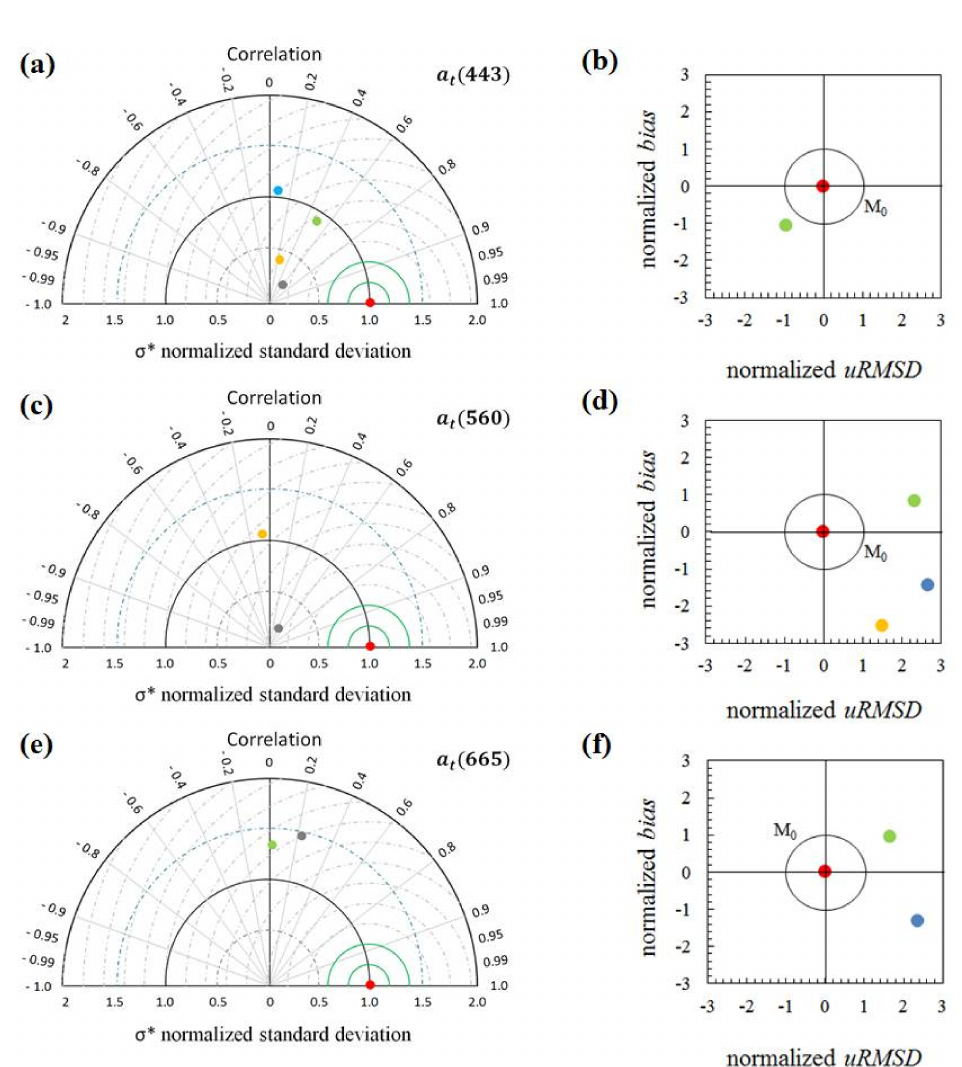
Figure 4. Taylor diagrams for a t ( λ ) at ( a ) 443 nm, ( c ) 560 nm, and ( e ) 665 nm. Target diagrams for a t ( λ ) at ( b ) 443 nm, ( d ) 560 nm, and ( f ) 665 nm. Color symbols indicate the following: QAA Lv5 (gray dot), QAA Lv6 (yellow dot), QAA M14 (blue dot), QAA OMW (green dot), and the reference observation (red dot). The black circle in the target diagrams (M 0 ) corresponds to a normalized total RMSD of 1.0; therefore, all points between this circle and the origin are positively